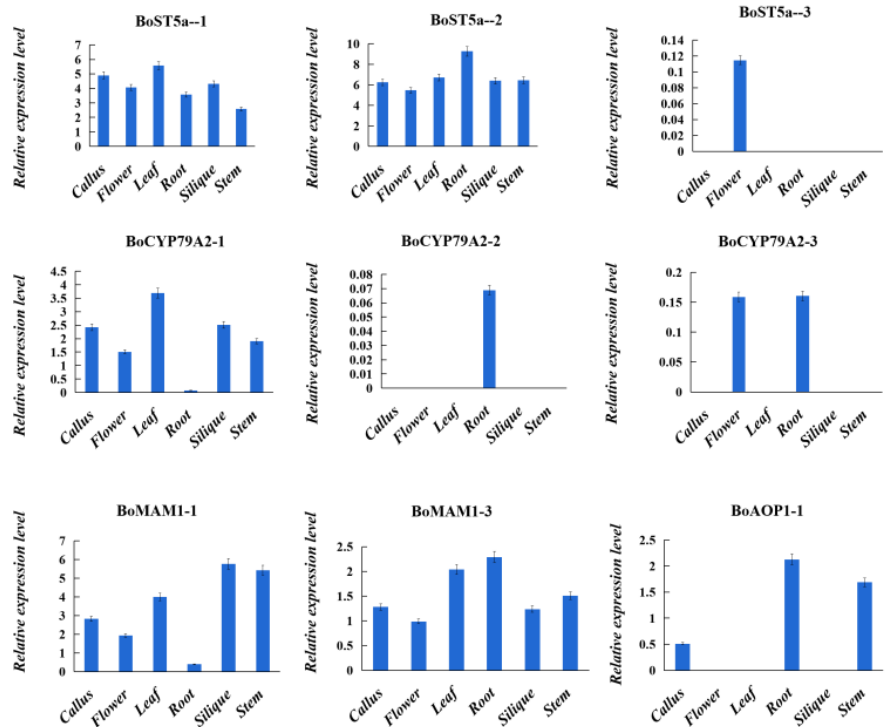
Figure 6. Relative expression levels of nine key glucosinolate biosynthetic genes in different tissues of cabbage.